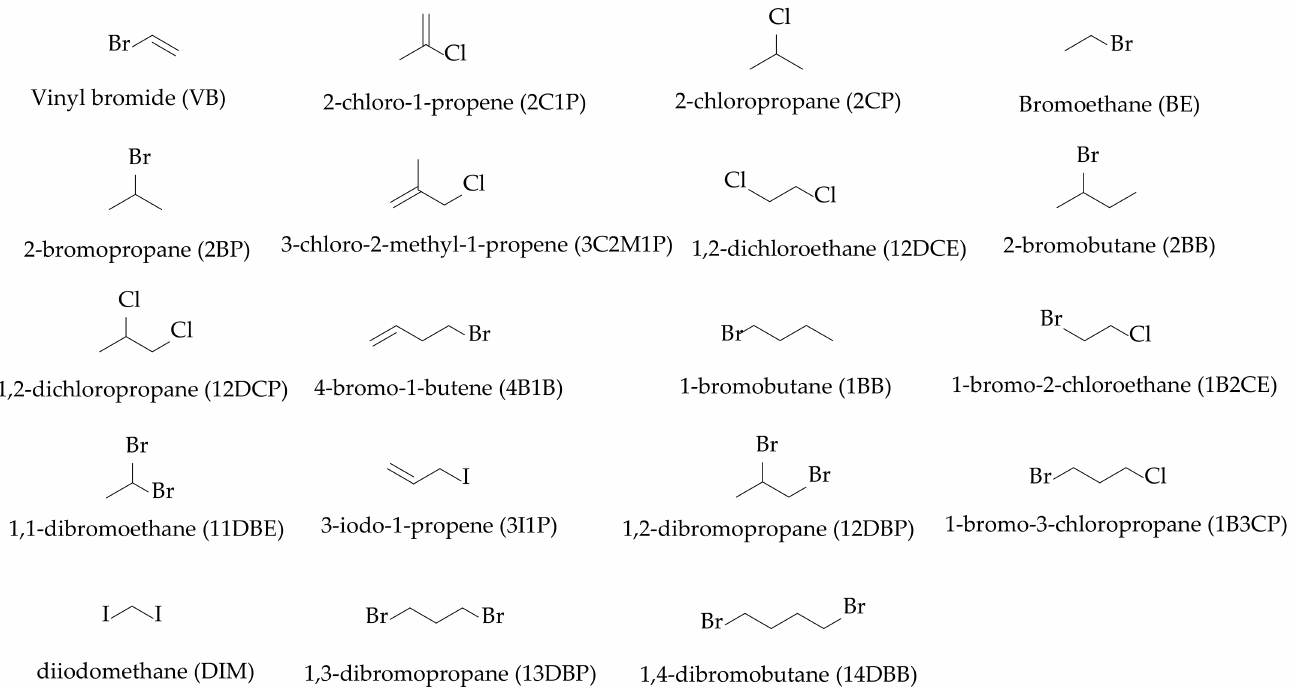
Figure 1. Chemical structures and abbreviations of the 19 selected alkyl